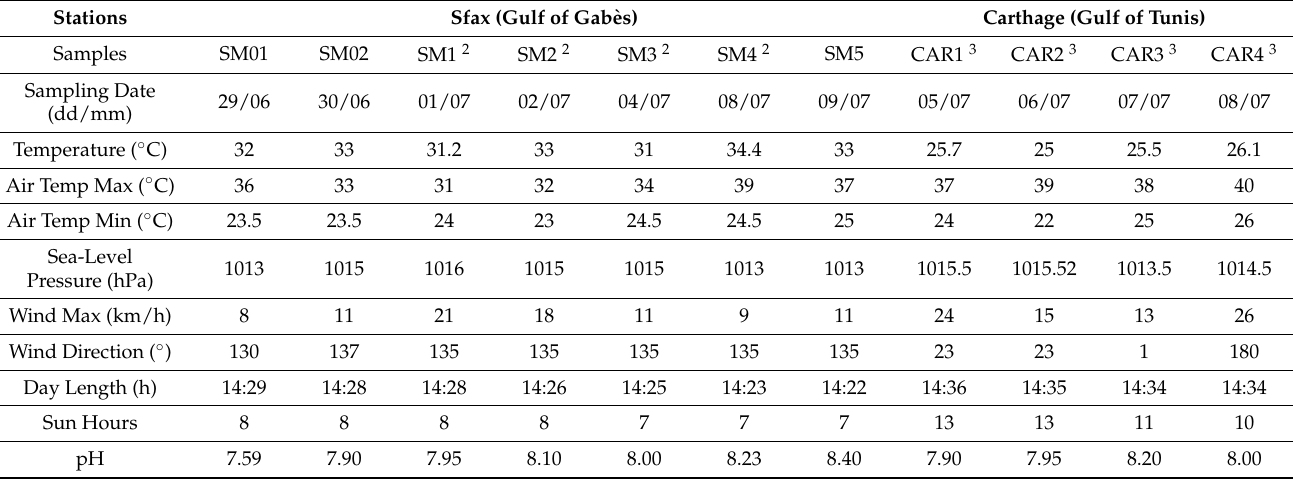
Table 1. Environmental variables obtained at the Sfax (Sidi Mansour (SM)) and Carthage (CAR) sites during the blooms of Alexandrium minutum and Gymnodinium impiducum ,